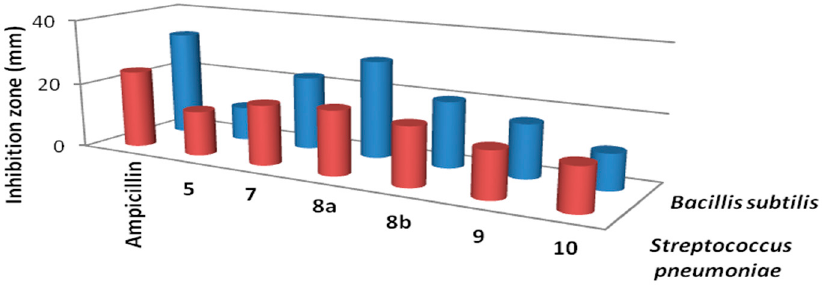
Figure 2. Activity of the synthesized thiophene derivativesagainstGram positive bacteria.